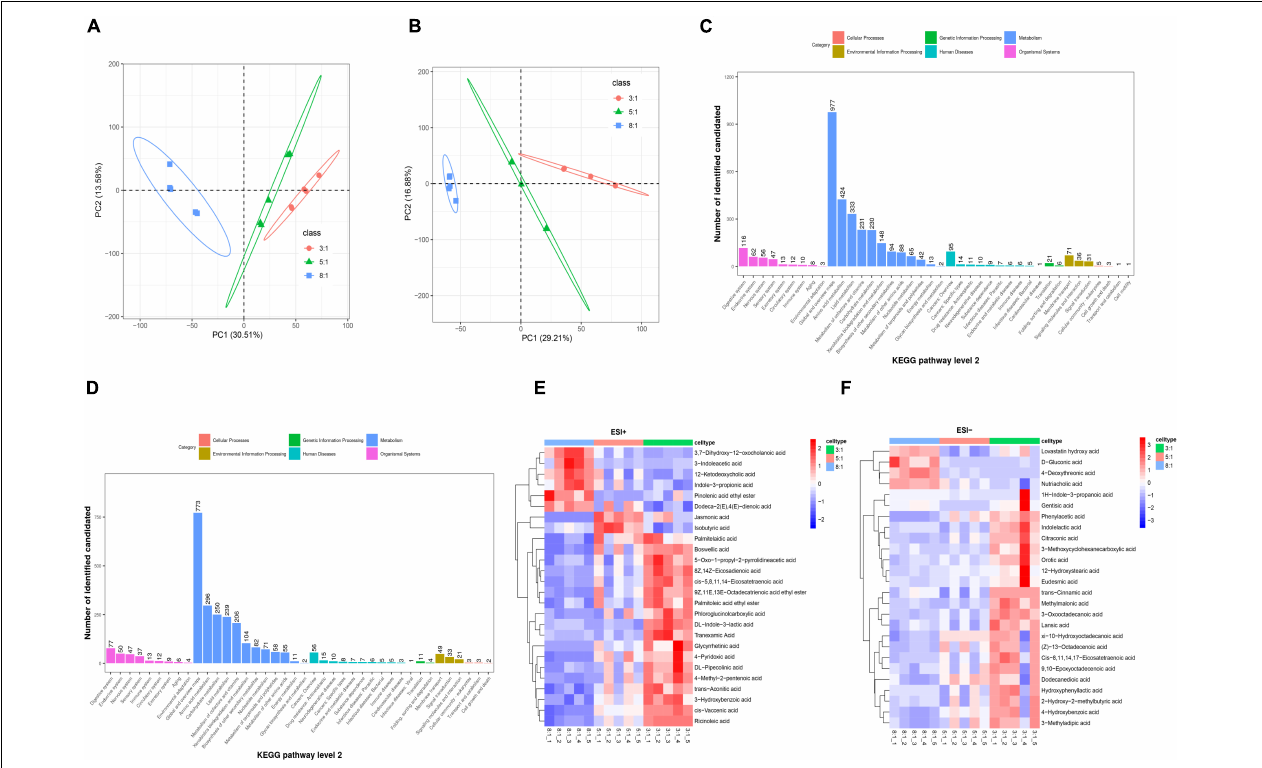
FIGURE 4 | The effects of dietary n-6/n-3 PUFA ratio on colonic metabolites. (A) Principal coordinates analysis (PCA) plot of colonic metabolites (ESI +) of Heigai pigs in different groups. (B) PCA plot of colonic metabolites (ESI-) of Heigai pigs in different group. The ellipse represents the 95% confidence interval of each group. (C,D) Kyoto Encyclopedia of Genes and Genomes (KEGG) pathway enrichment of these significant differential metabolites identified among three different groups under ESI + and ESI- modes. (E,F) Heatmap of colonic metabolites under ESI + and ESI- modes in each group. Only metabolites with P < 0.05 are